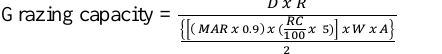
Figure 2. Mean vegetation reflectance from Landsat 8 bands (n=40) showing the mean, 95% upper confidence limit (UCL), and 95% lower confidence limit (LCL) of